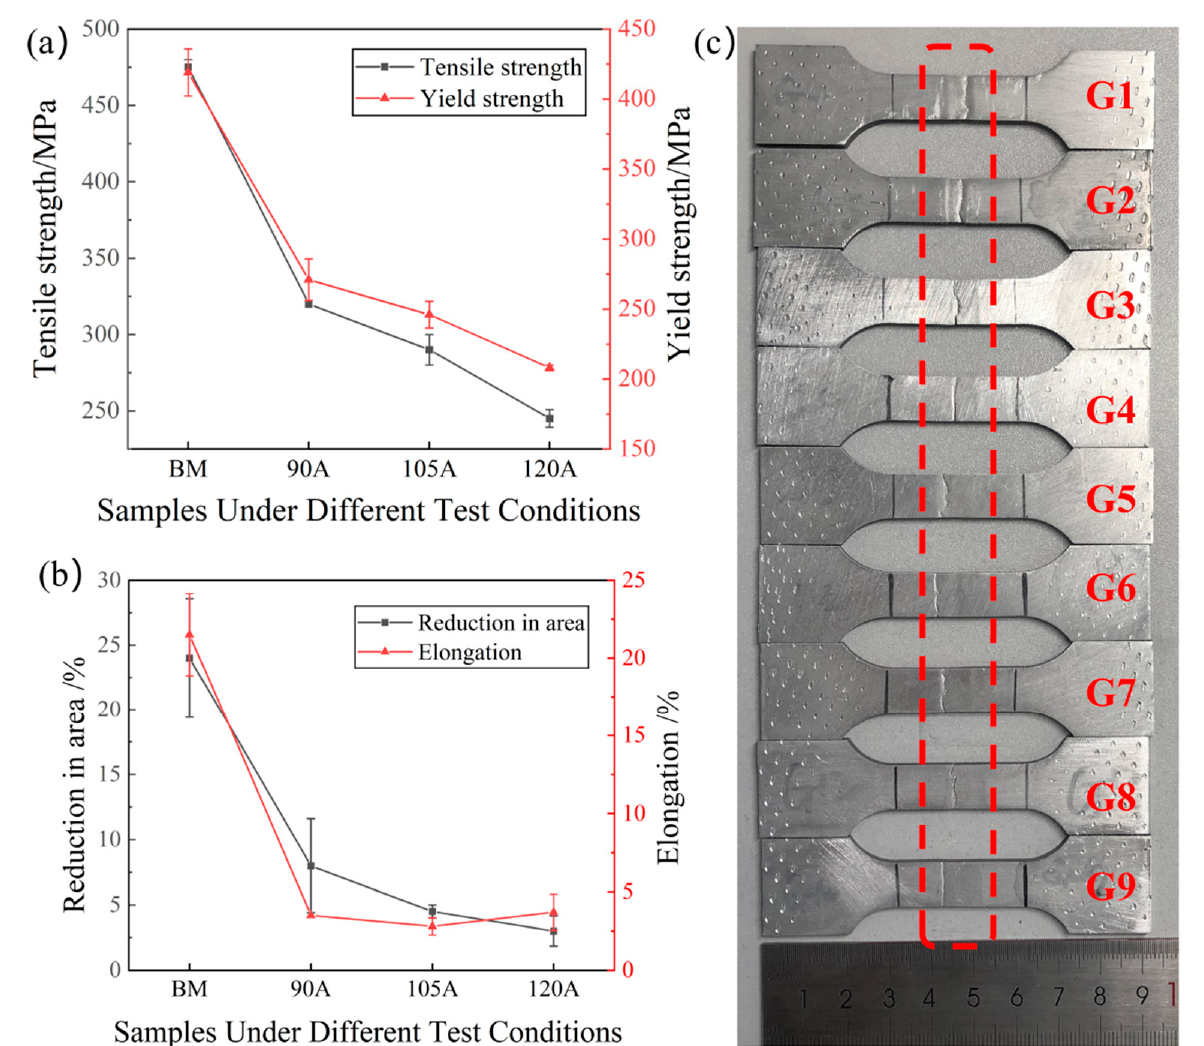
Figure 12. Mechanical properties under different weld heat input: ( a ) tensile strength and yield strength; ( b ) shrinkage at section and elongation after break; ( c ) macroscopic photos of tension.